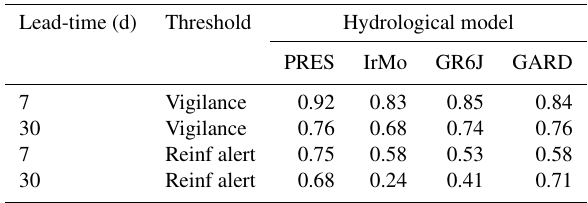
Table 3. Probability of detection to be under the vigilance and re- inforced alert threshold for each model and for the 7 and 30d lead- times for the Ill River at